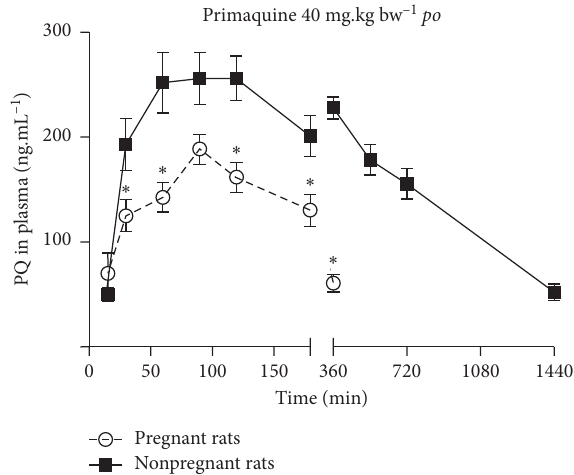
Figure 1: Primaquine (PQ) disposition in nonpregnant and pregnant rats: plasma concentration-time curves for PQ (40mg.kg · bw − 1 ) administered by the oral (gavage) route ( N � 10 per group). ∗ p < 0 . 05.